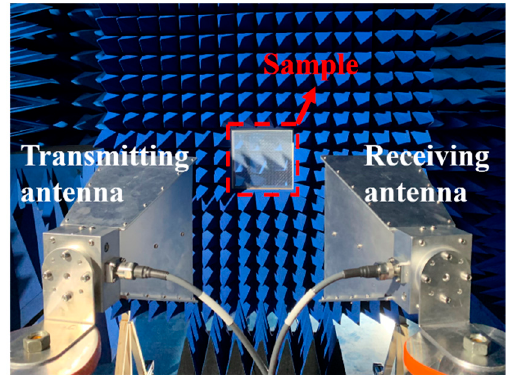
Figure 8. Measurement setup.